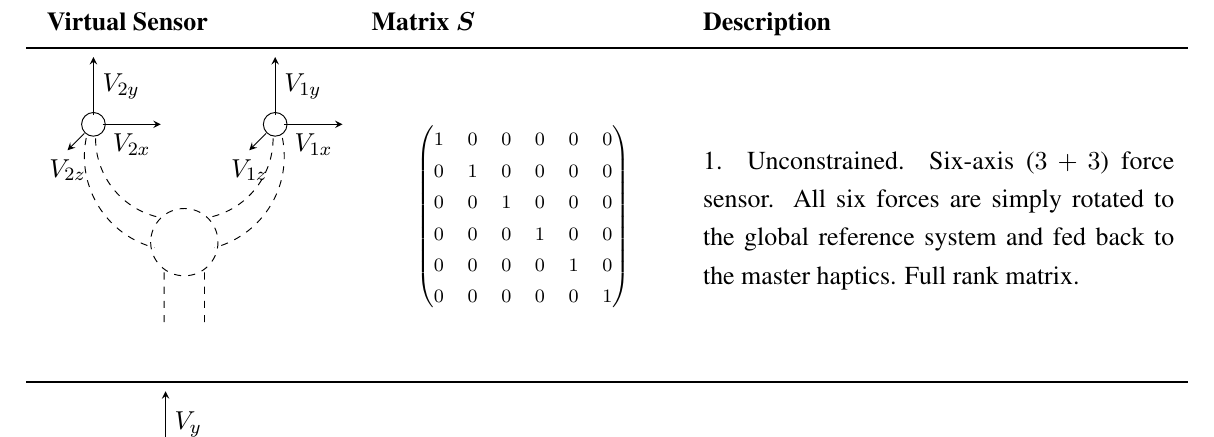
Table 3. Set of five virtual sensor configurations for the two-fingered virtual grasper used in the